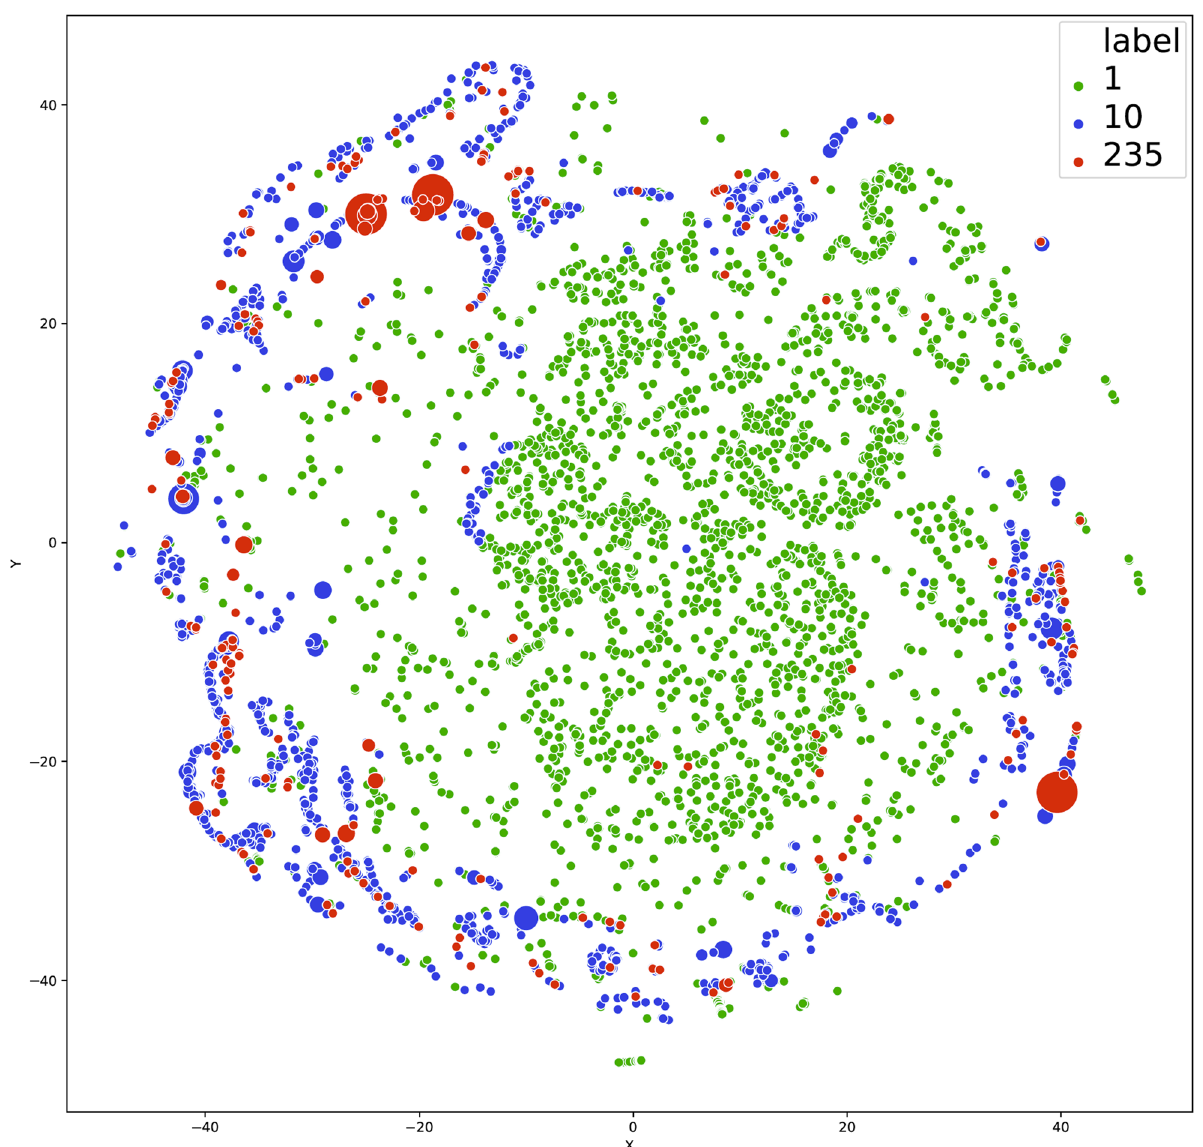
Fig. 5 Interactive exploration of thermal conductivity. We map the materials by projecting their XRD spectra to 2D space. Each red point represents a material with known thermal conductivity with the size of dots representing their thermal conductivity values. The green and blue dots represent the materials with unknown thermal